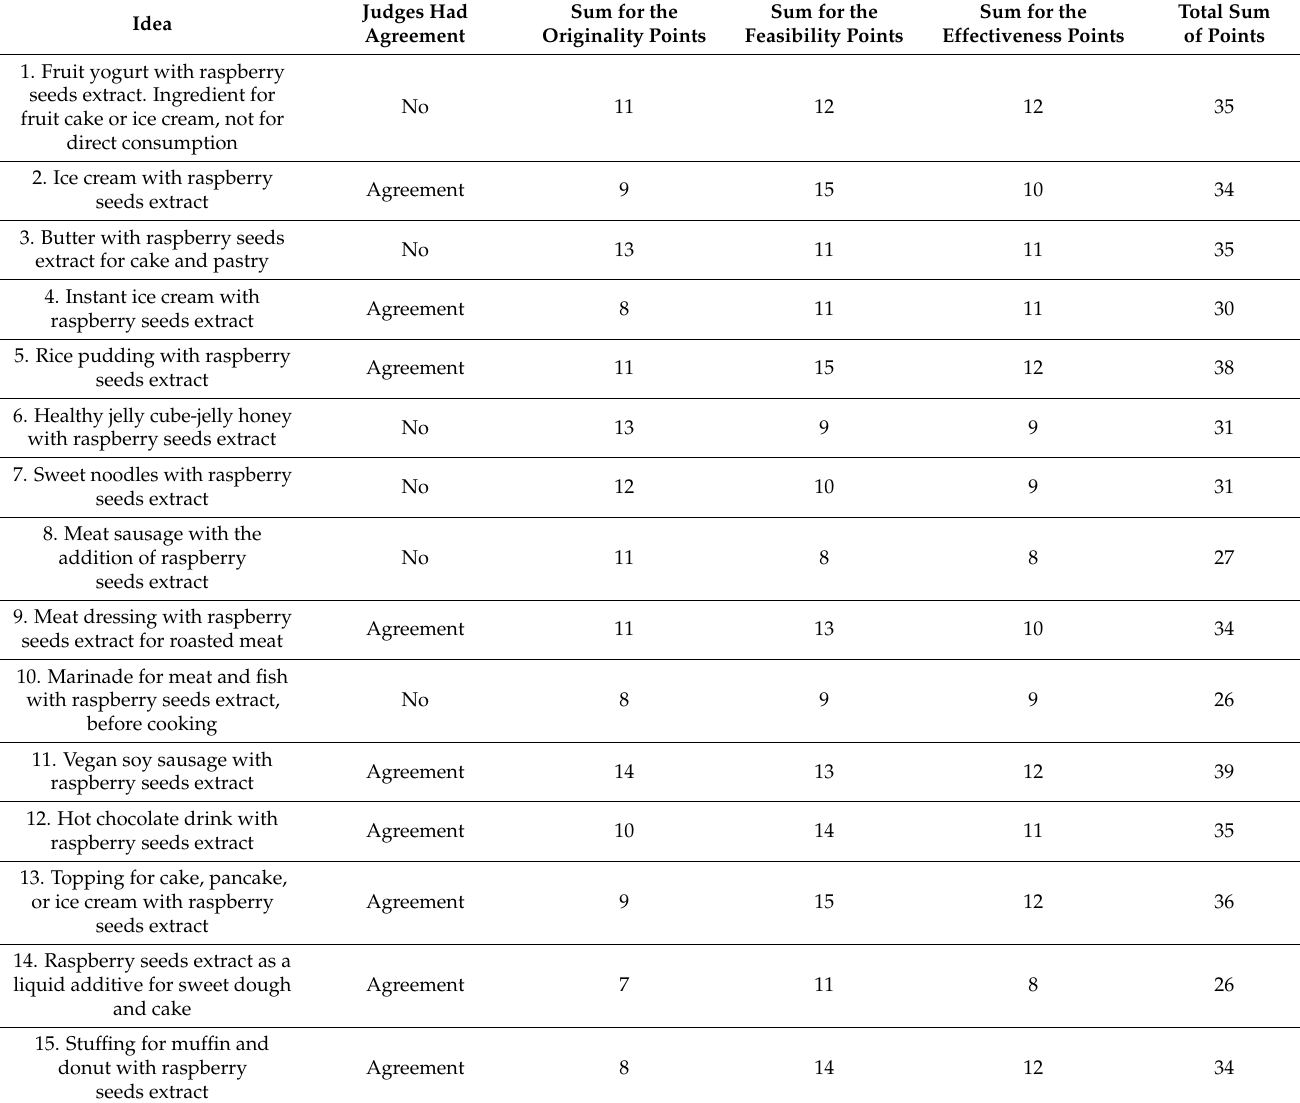
Table 2. Final list of NFP ideas and sums of the judges’ evaluation points. Judges’ agreement was recorded when at least two of the three idea-quality dimensions were identical. Judges Had Sum for the Sum for the Sum for the Total Sum Agreement Originality Points Feasibility Points Effectiveness Points of